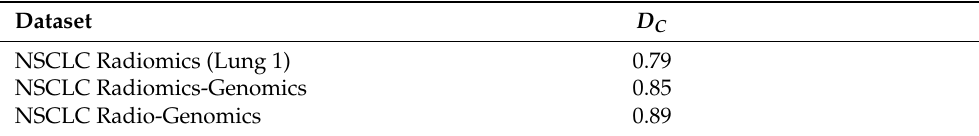
Figure 6. Output of HU multilevel thresholding from five different patients (CT Scans) at five different positions (First Slice, two middle slices, Slice 250, and last Slice). Table 3. HU-based segmentation evaluation using dice ( D C ) coefficient on the TCIA NSCLC